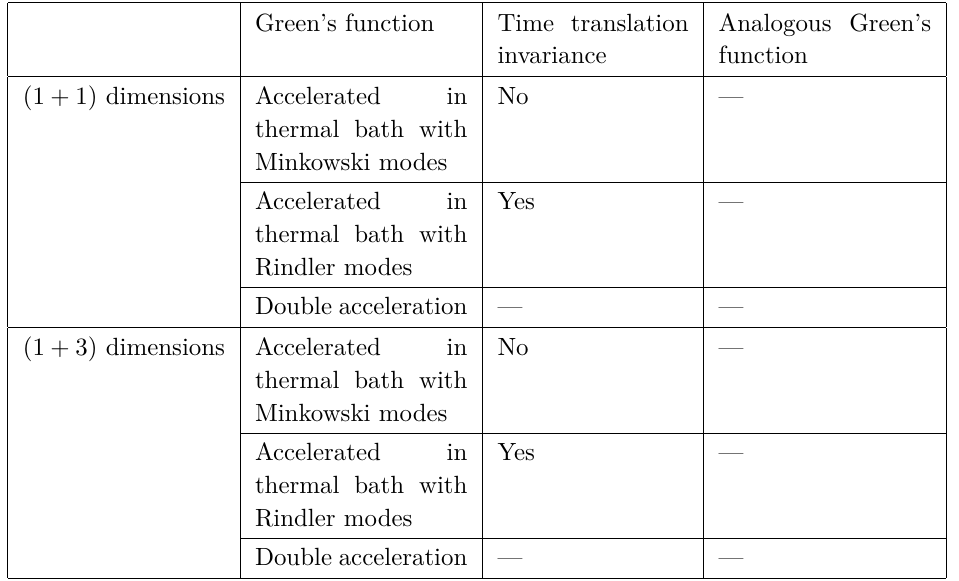
— — Table 4 . Characteristics of different Green’s functions (observers with uniform acceleration in thermal bath or with double